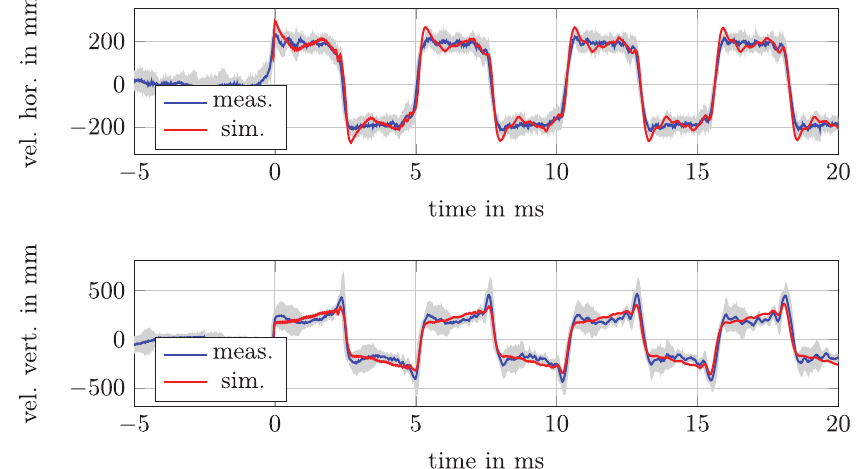
Figure 14. Velocity of experiment (blue) and simulation (red) in comparison directly after plucking in the middle. The string is measured 15 mm beside the